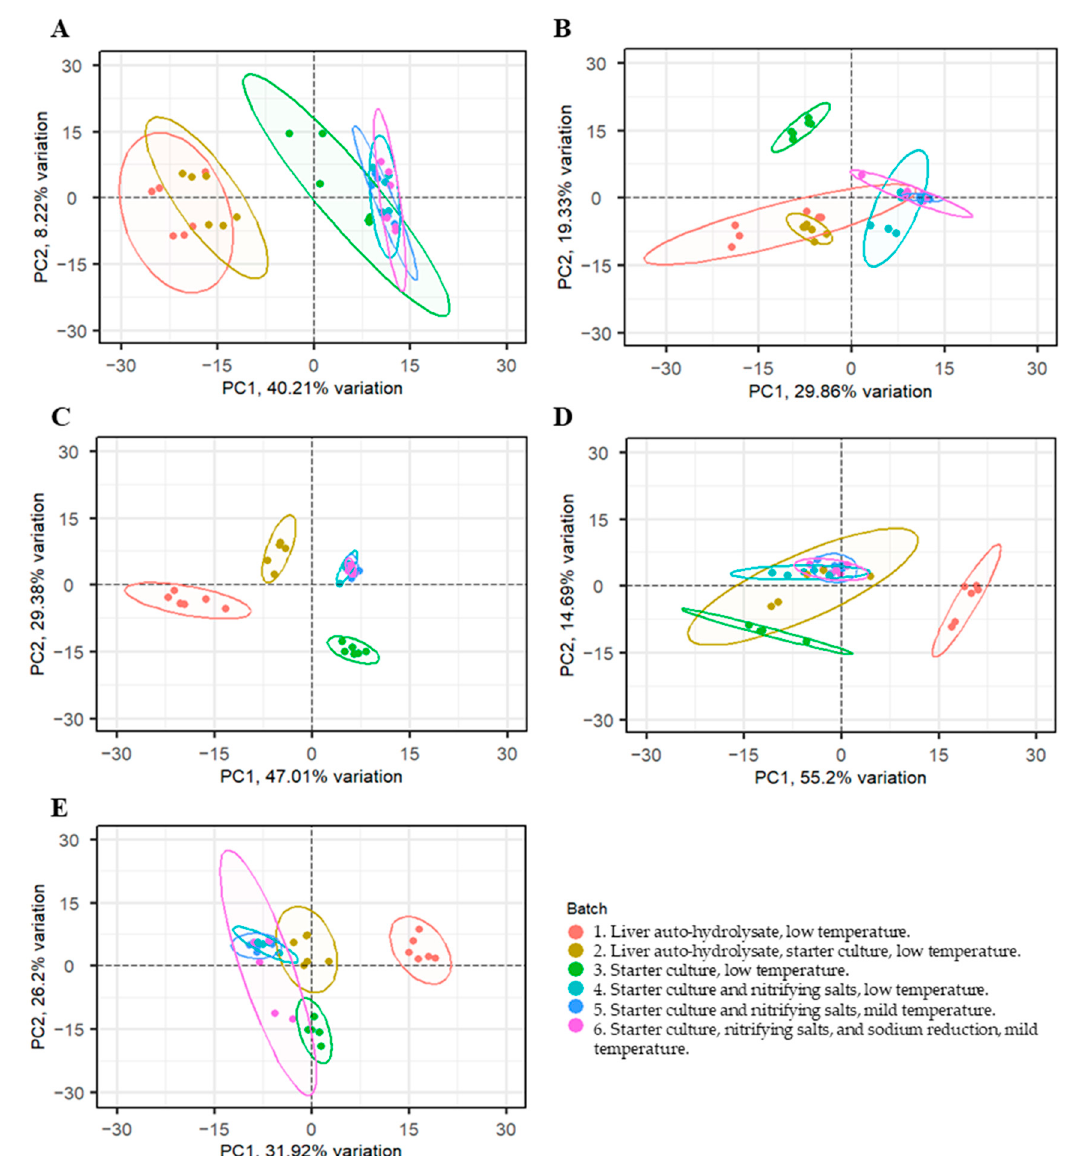
Figure 2. Principal component analysis plots representing the beta diversity analysis comparing every batch by time t0 ( A ), t4 ( B ), t12 ( C ), tRip ( D ) and tStor ( E ). every batch by time t0 ( A ), t4 ( B ), t12 ( C ), tRip ( D ) and tStor ( E